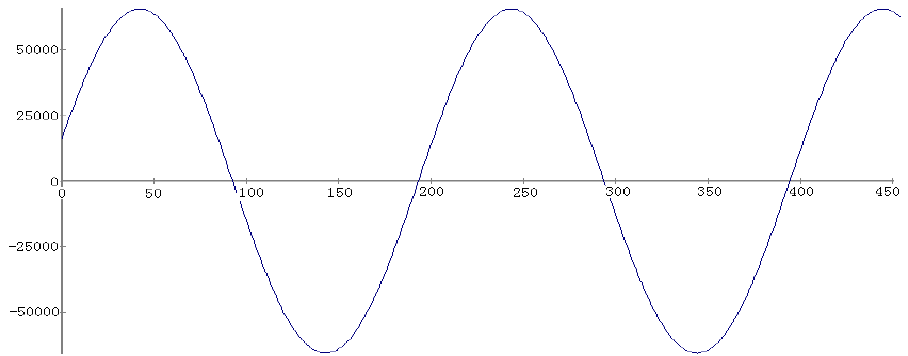
Fig. 5 result of new FPGA structure